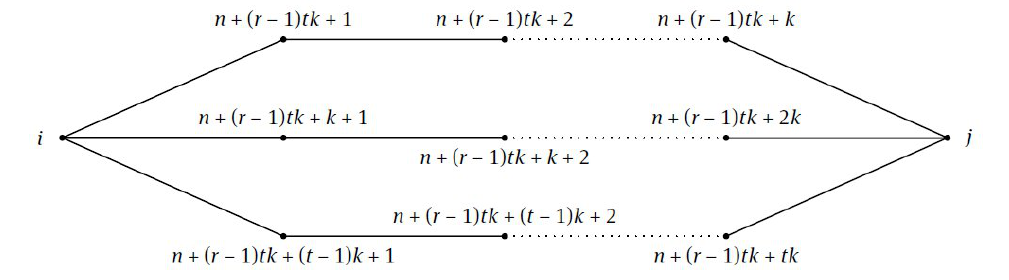
Fig. 4. Labeling of a path bundle of T k ,